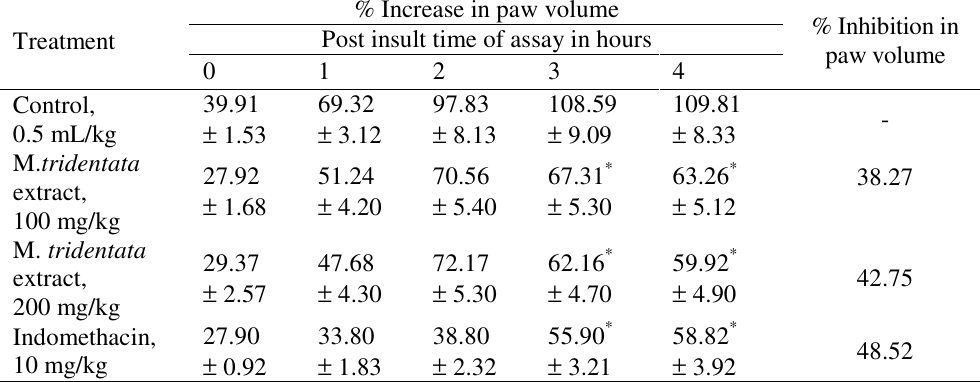
Table 2 . Anti-inflammatory activity of ethanol extract of M. tridentata against carrageenan induced paw